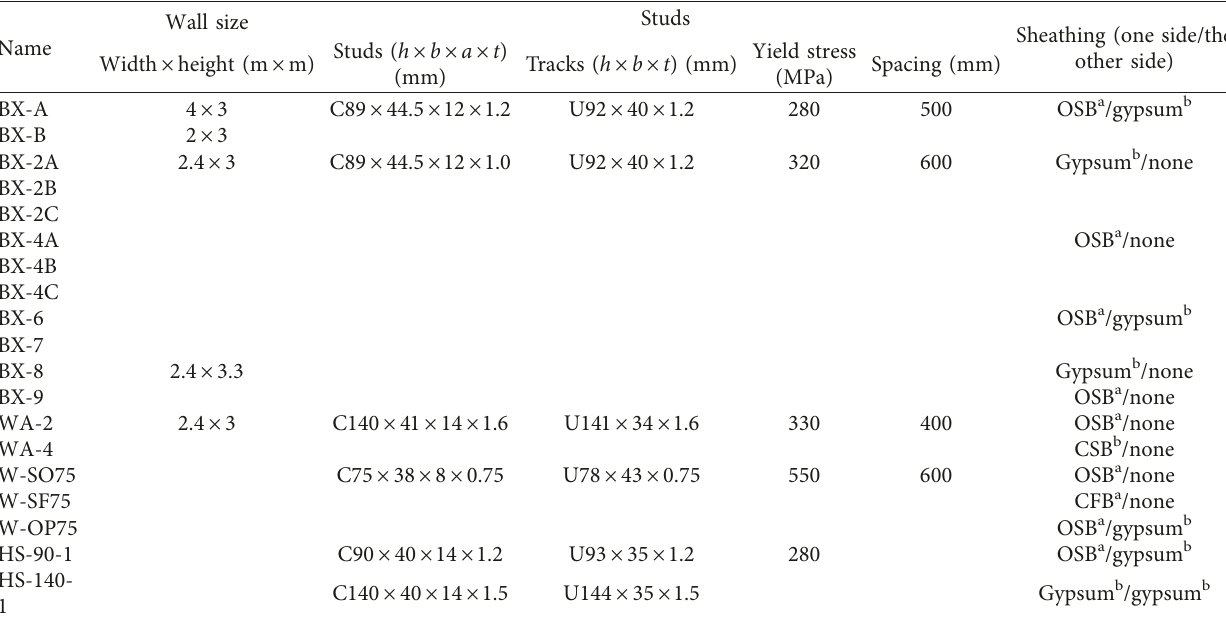
Table 1: Summary of the test